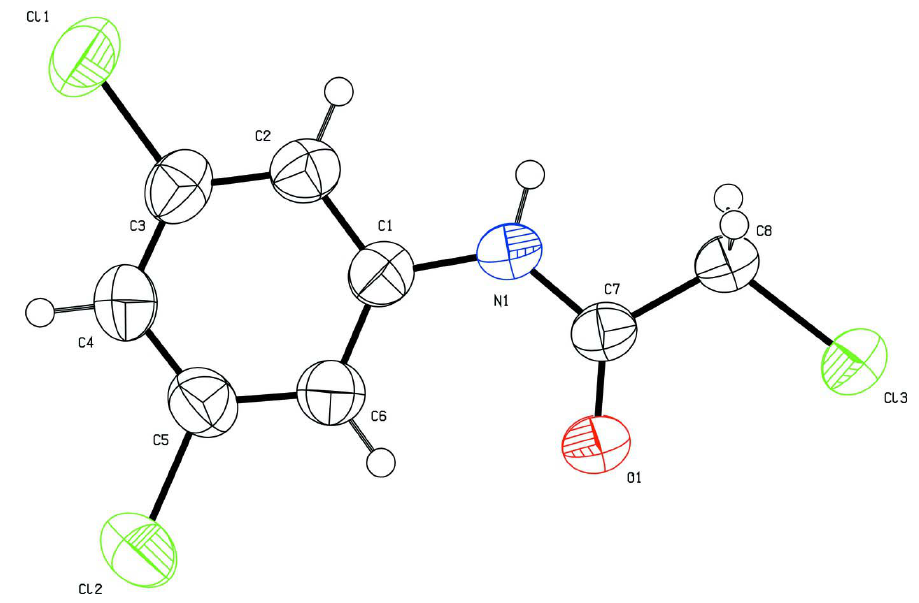
Figure 1 Molecular structure of the title compound, showing the atom labeling scheme. The displacement ellipsoids are drawn at the 50% probability level.